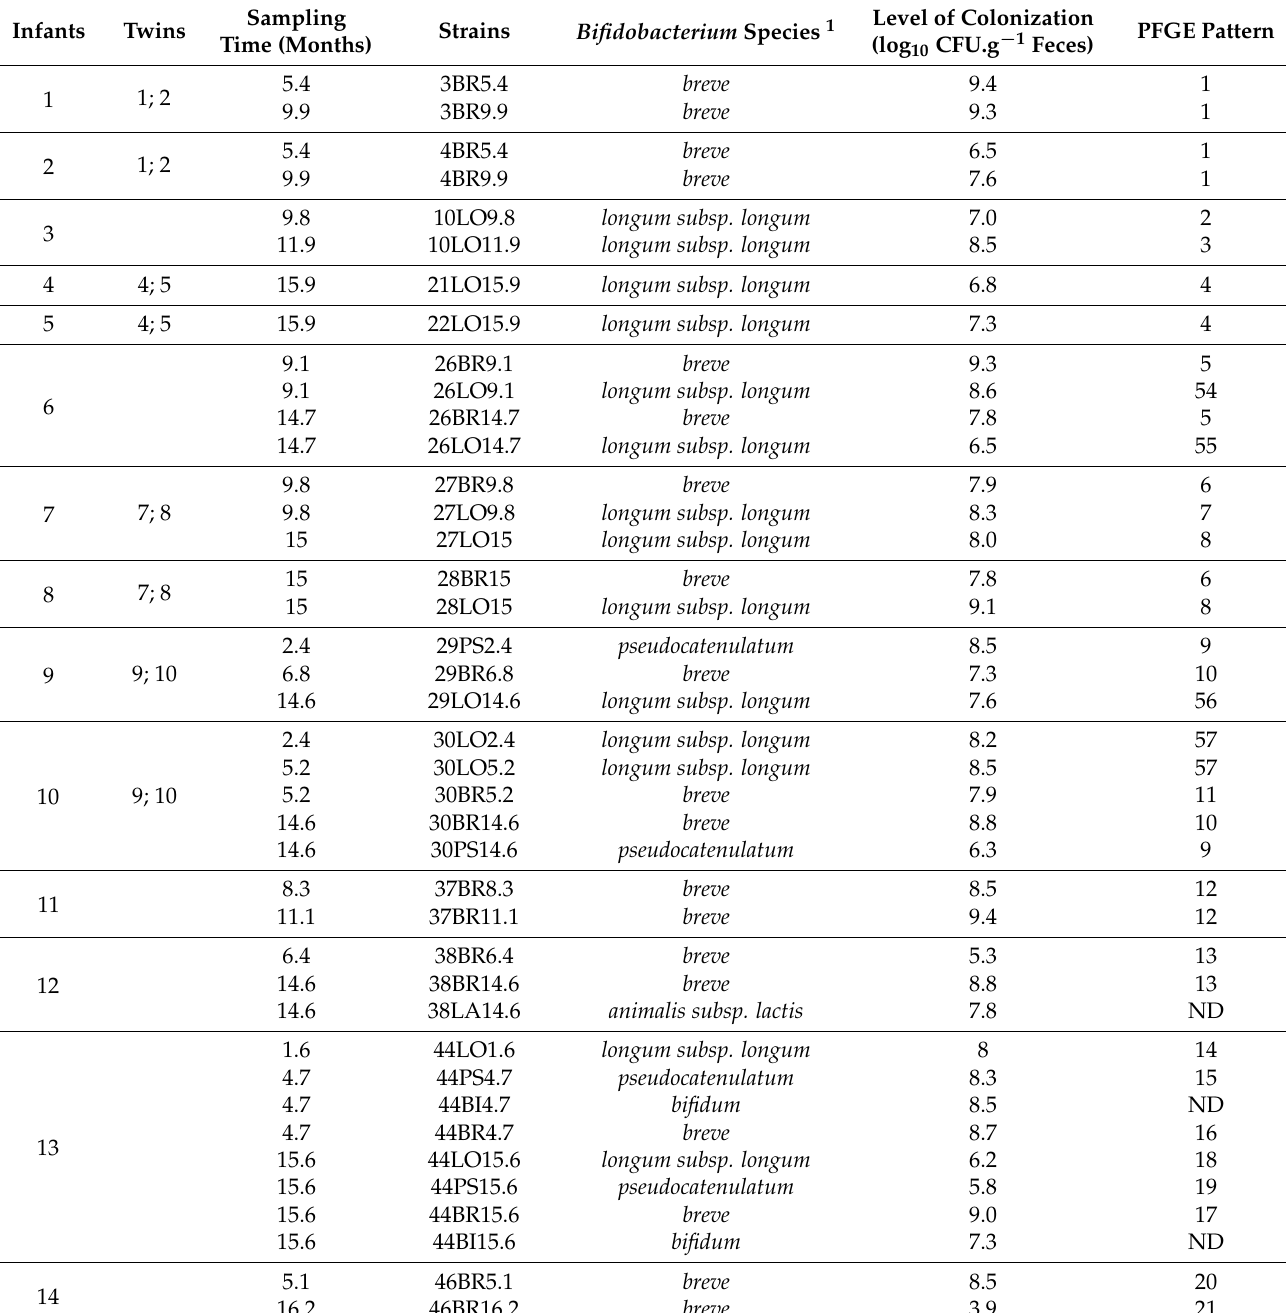
Table 1. Dominant bifidobacteria isolated from feces of neonates born